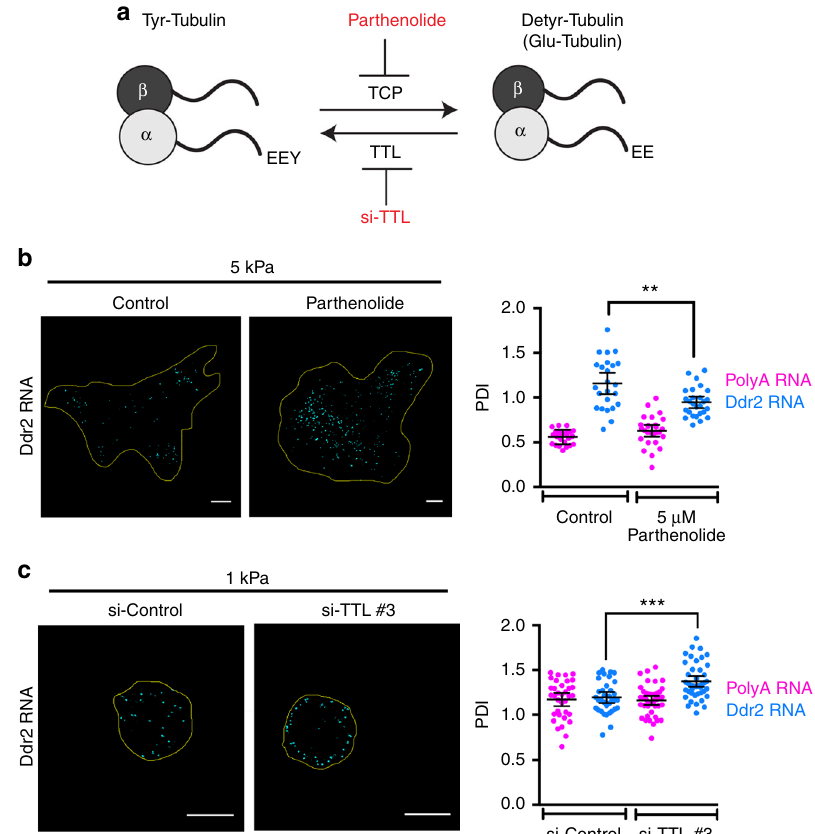
Fig. 5 Detyrosinated microtubules are necessary and suf fi cient for the peripheral localization of Ddr2 RNA. a Schematic depicting the microtubule detyrosination cycle. Indicated is the C-terminal tyrosine residue removed by an unknown carboxypeptidase. The effects of parthenolide treatment or knockdown of tubulin tyrosine ligase (TTL) are also shown. b FISH analysis of control or parthenolide treated cells plated on 5 kPa substrates. Representative Ddr2 RNA distributions and PDI values of Ddr2 and polyA RNA are shown. c FISH analysis of control or TTL knockdown cells plated on 1 kPa substrates. Representative Ddr2 RNA distributions and PDI values of Ddr2 and polyA RNA are shown. For PDI quanti fi cations, bars represent the mean with 95% con fi dence interval. Points indicate individual cells analyzed in at least two or more independent experiments. p -values: *** < 0.001 by analysis of variance with Bonferroni ’ s multiple comparisons test. Scale bars: 10 μ